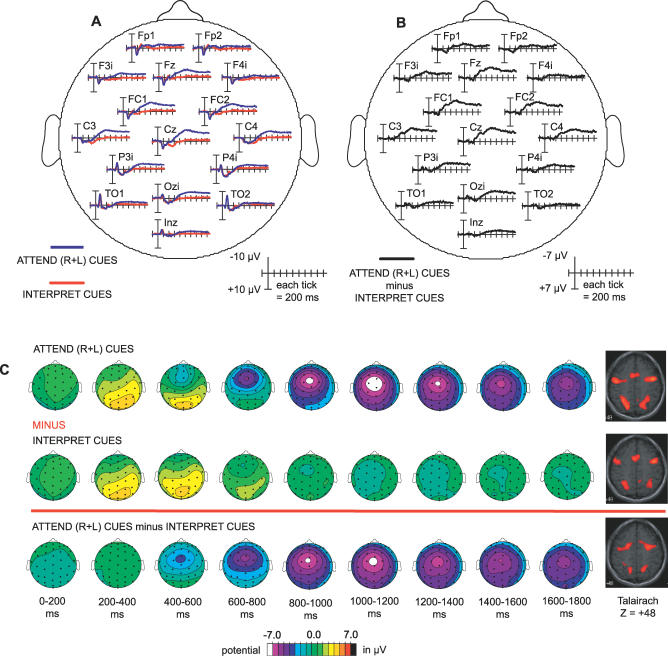
Cue-Related ERP and fMRI Responses(A) Grand average across participants (n = 13) of the ERP traces from 16 of the channels across the scalp of the cue-triggered responses to attend-cue trials (collapsed over right and left and also across cue-only and cue-plus–late-target trials), overlaid on the cue responses for interpret-cue trials, starting 200 ms before cue onset until 1,900 ms (which was the onset of a target on trials with a late target).(B) Grand-average (n = 13) ERP difference waves of the attend-cue responses minus interpret-cue responses from (A).(C) ERP topographic maps of these scalp-potential distributions, averaged over 200-ms windows, for attend cues, interpret cues, and their difference waves, starting at the onset of the cues and ending 100 ms before the time of a possible late target presentation. On the right are shown the corresponding fMRI activations (at Talairach height of z = +48) for the attend-cue–only and interpret-cue responses (corrected for overlap) and for the attend-cue–versus–interpret-cue contrasts observed in the identical conditions in the corresponding Woldorff et al. (2004) fMRI study [22].